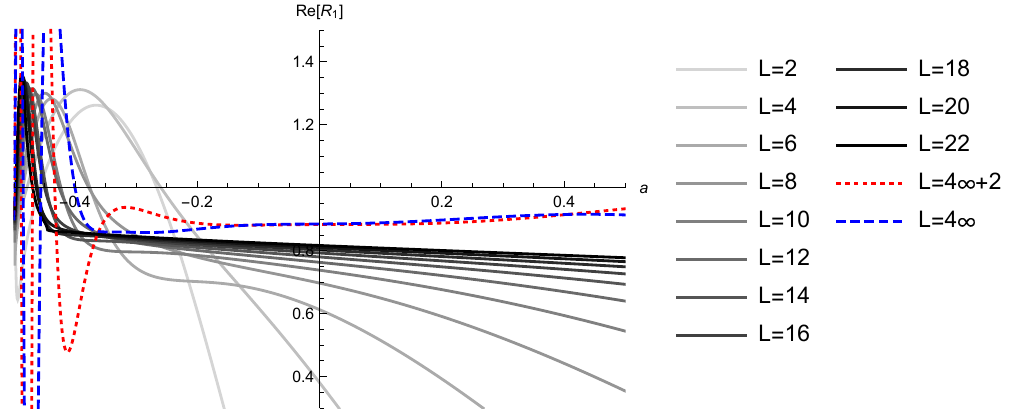
Figure 21 . Plots of the real part of R 1 (A.3) of Φ D dashed lines are extrapolations to L = 4 k + 2 and L = 4 k ( k → ∞ ), respectively. The horizontal axis denotes the value of the parameter a at Re R 1 = 1